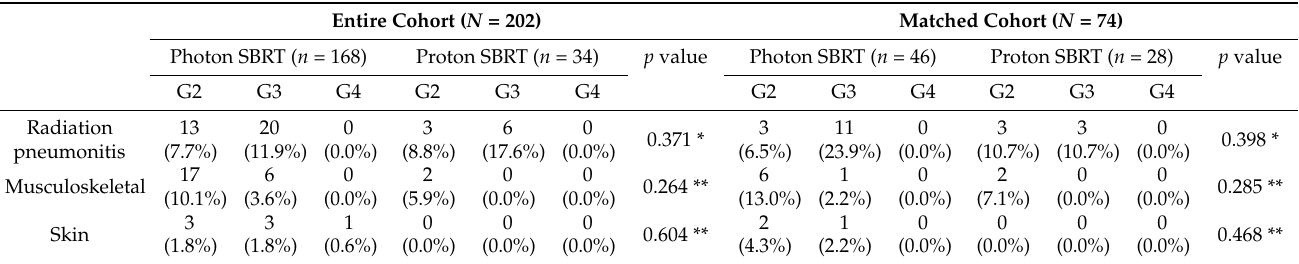
Table 3. Toxic events after SBRT.